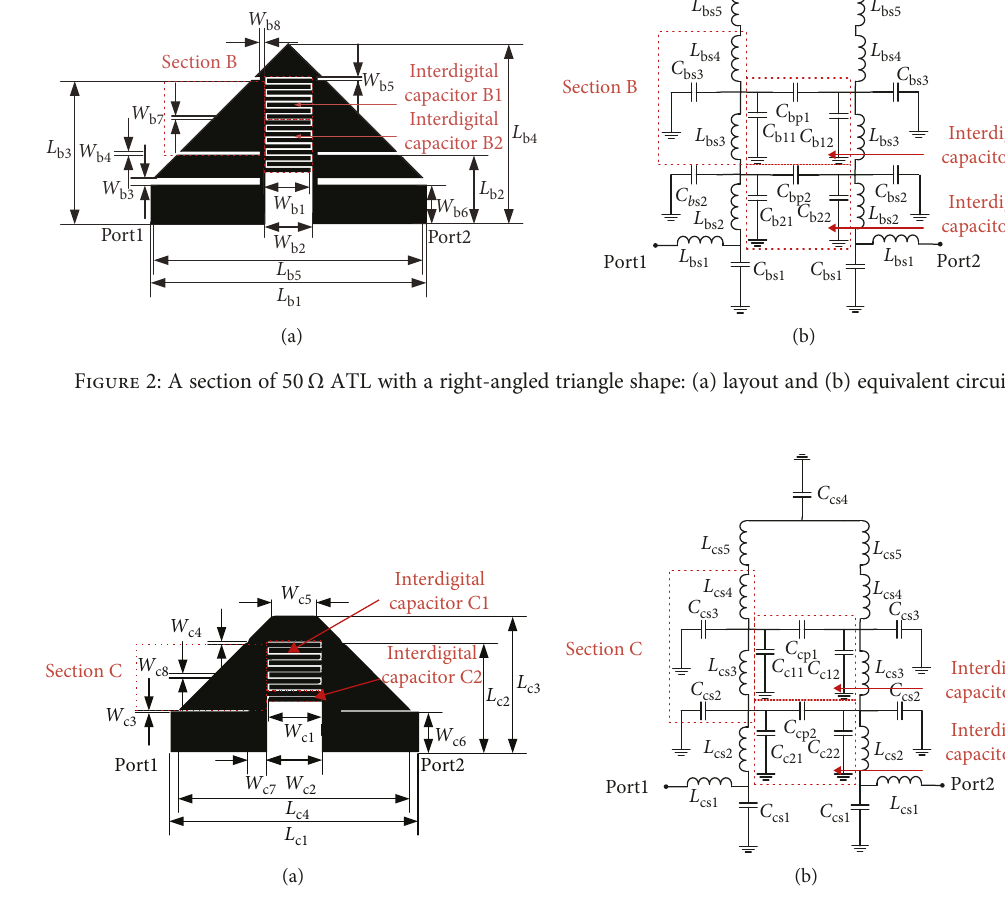
Figure 3: A section of 35.4 Ω ATL with an isosceles trapezoid shape: (a) layout and (b) equivalent